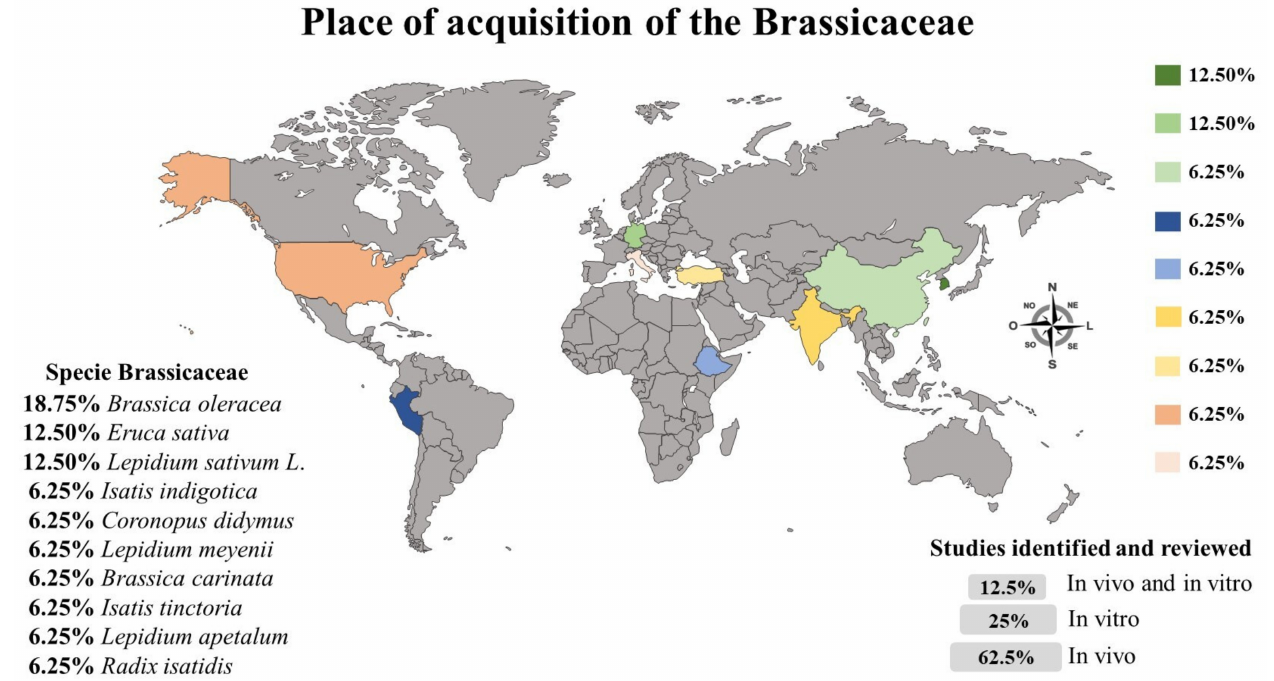
Figure 2. The places of acquisition of the Brassicas used in the studies are represented in Figure 2, as well as the types of studies (in vitro and/or in vivo) developed and the Brassicaceae species studied. The place of acquisition was reported in 31.25% of the studies reviewed, and the remaining studies did not report this information; 12% of the studies did not report the species